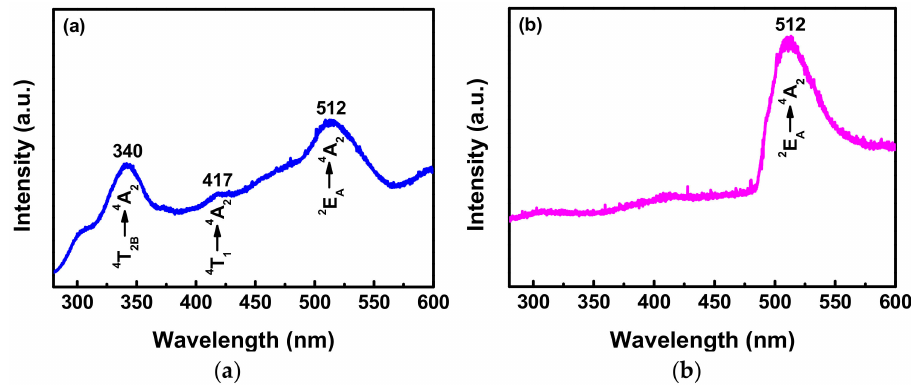
Figure 8. RT PL spectra of the ZnGa 2 O 4 films deposited on ( a ) sapphire and ( b )